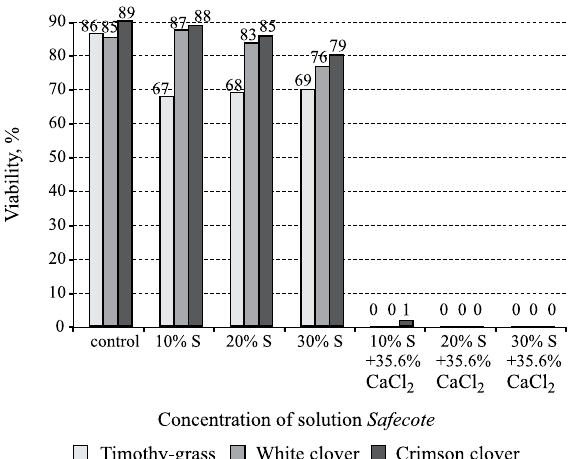
Fig. 2. Viability of timothy grass, white and crimson clovers in soil (during six weeks)